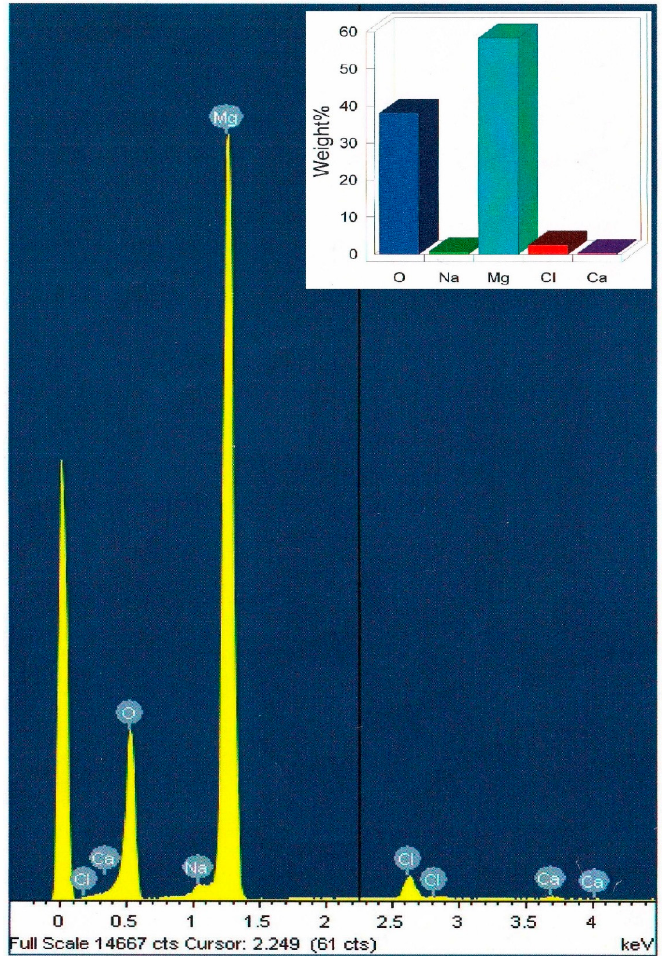
Figure 4. EDX spectra of the 10 wt% chitosan-MgO nanocomposite hybrid film. Inset is the quantitative result.